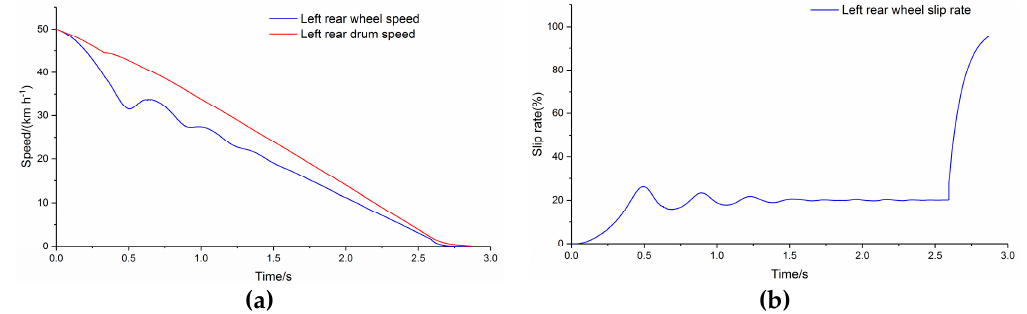
Figure 11. ( a ) Comparison of main drum speed and wheel speed; ( b ) slip rate after relaxation.